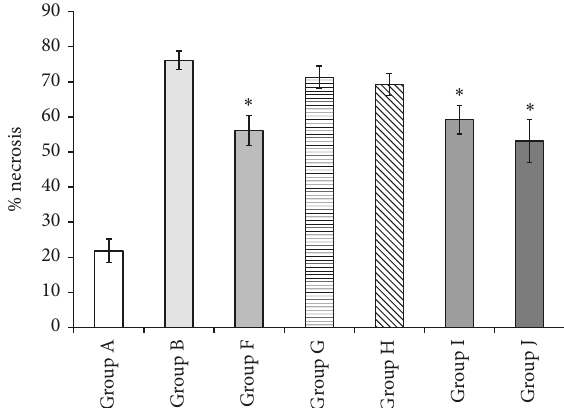
Figure 3: Noninvasive IP suppressed tissue necrosis in diabetic skin flaps.GroupA:healthycontrols( 21.7±3.4 %);GroupB:STZinduced diabetic controls ( 76.2±2.6 %); Group F: pharmacologically induced IP using the nitric oxide donor Spermine ( 56.1 ± 4.3 %); Group G: nitric oxide synthase blocker L-NAME ( 71.3 ± 3.2 %); Group H: nitric oxide synthases blocker L-NAME + tourniquet ( 69.25±3.2 %); Group I: 30min preischaemic nitric oxide donor ( 59.2 ± 4.1 %); Group J: postischaemic nitric oxide donor ( 53.1 ± 6.2 %); results are presented as mean ± SEM. ∗ 𝑝 < 0.05 was considered statistically